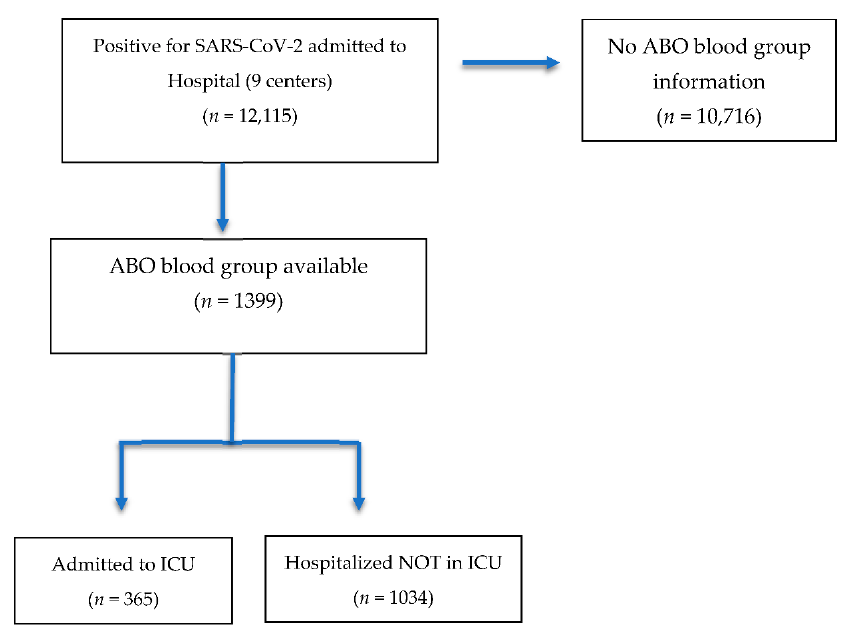
Figure 1. Flow chart of selected cases.